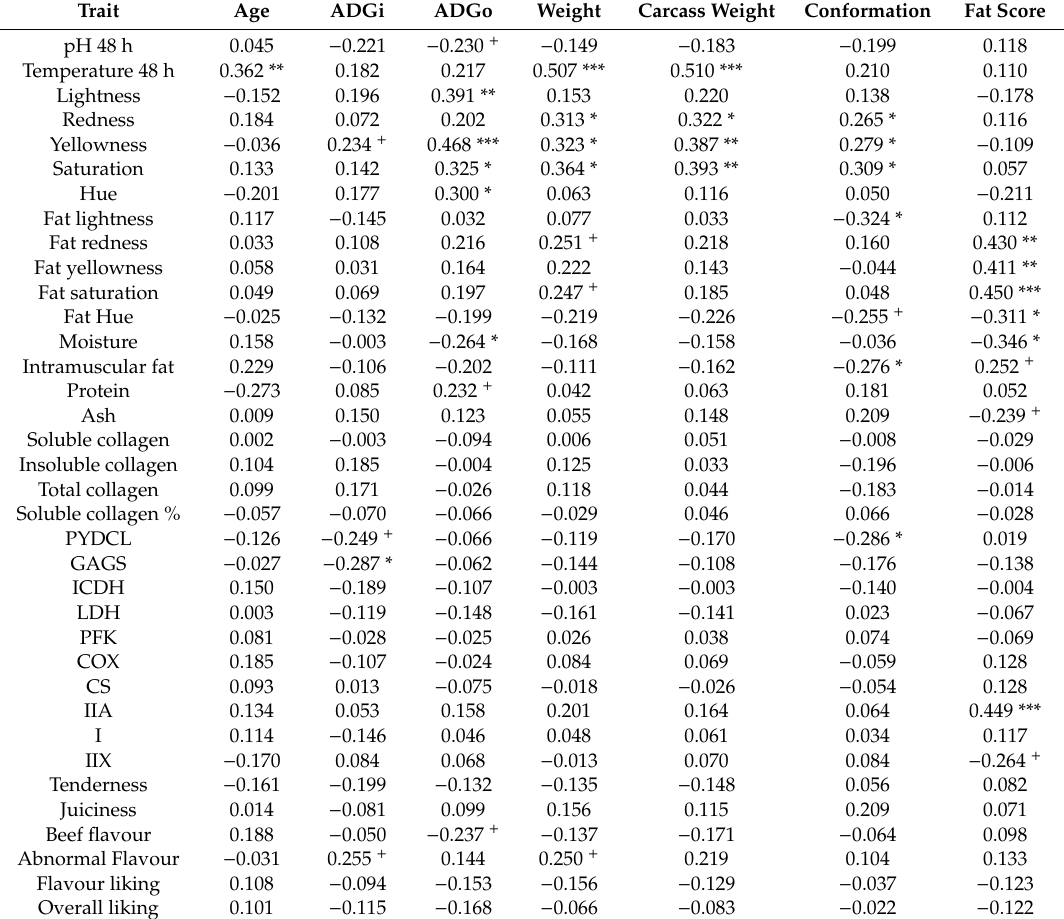
Table 6. Partial correlations (r) between animal / carcass traits and longissimus muscle biochemical / sensory traits 1 .